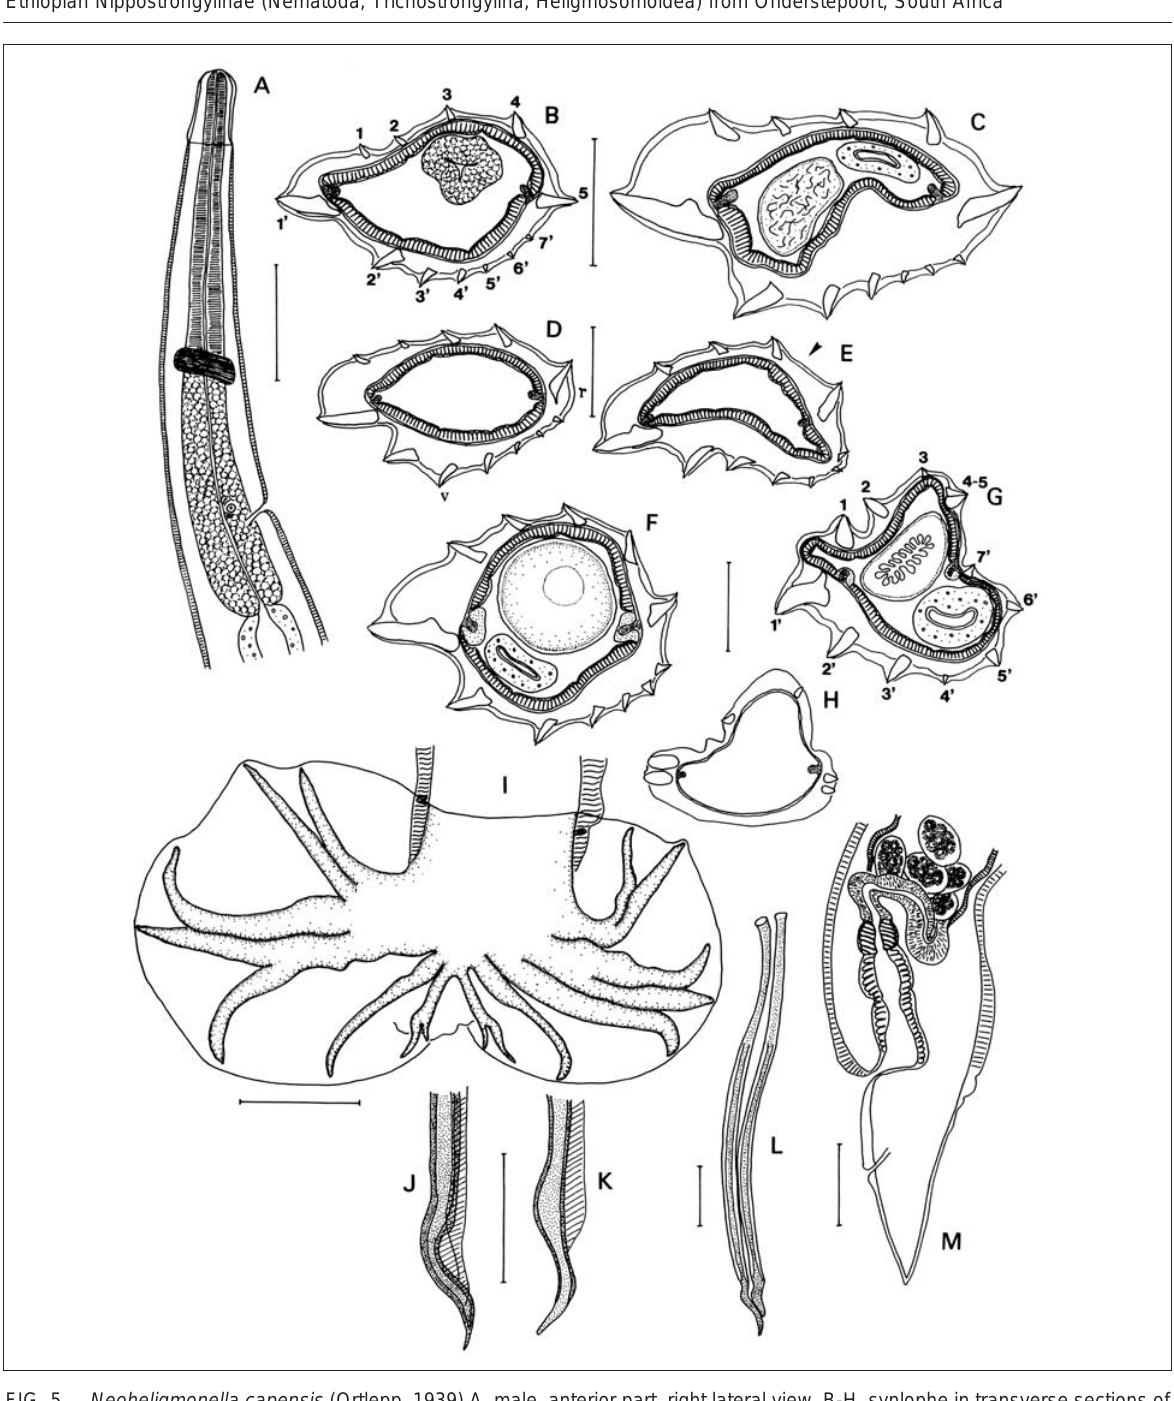
FIG. 5 Neoheligmonella capensis (Ortlepp, 1939) A, male, anterior part, right lateral view. B-H, synlophe in transverse sections of a male (5.2 mm long) and a female (8.9 mm long). B–E, male, B, at the level of the oesophago-intestinal junction, C, at the end of the anterior third of body, D, at mid-body (3.1 mm from the apex), E, at 1.3 mm anterior to the caudal bursa; F–H, female, F, at mid-body (3.4 mm from the apex), G, at the level of the infundibulum, H, just anterior to the vulva. I, male, caudal bursa, ventral view. J, K, dissected tips of the spicules, J, right spicule, ventral view, K, left spicule, ventral view. L, spicules in situ , ventral view. M, female, posterior part, left lateral view The ridges are numbered from left to right, no. 1–5 for the dorsal side, no. 1’–7’ for the ventral side. The arrows indicate the disappearance of the ridges. All the ridges are orientated as in Fig. 5D Abbreviations: r, right side, v, ventral